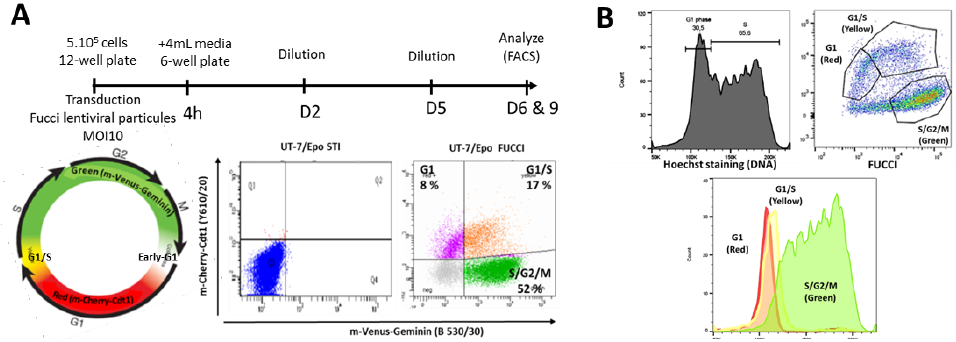
Figure 4. Generation of a UT7/Epo-STI cell line with stable expression of the Fluorescence Ubiquitination Cell Cycle Indicator (FUCCI). ( A ) Experimental design for the generation of the UT7/Epo-FUCCI cell line. Bottom: Two-color cell cycle mapping with the FUCCI2a Cell Cycle Sensor and right, flow cytometry analysis of exponentially growing UT7/Epo-STI and UT7/Epo-FUCCI cells. The profile shown corresponds to one representative experiment. ( B ) DNA content and FUCCI profiles for the same sample. Exponentially growing UT7/Epo-FUCCI cells were stained with Hoechst 33342. DNA content (Hoechst on the x -axis; cell count on the y -axis) and FUCCI proteins (m-Venus on the x -axis; m-Cherry on the y -axis) were concomitantly evaluated by flow cytometry. Bottom: Overlay of gated cell cycle populations, as determined by FUCCI analysis with DNA content profile.